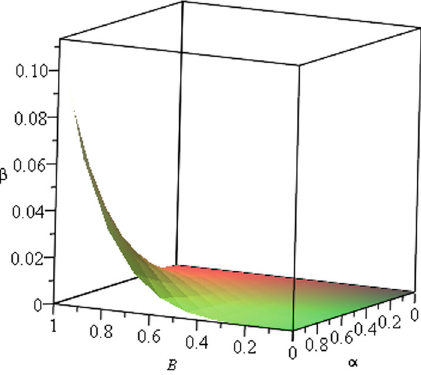
Fig. 6 The plot shows the causality with variables α , β and B